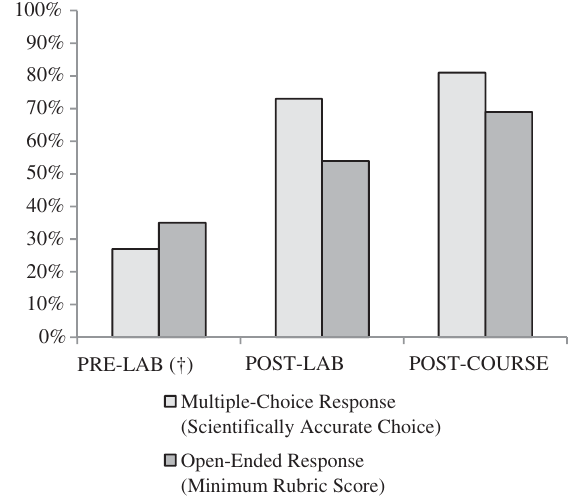
FIG. 2. Percentage of students meeting minimum criteria when asked about the apparent motion of stars near Polaris with respect to the horizon ( n ¼ 26 ).